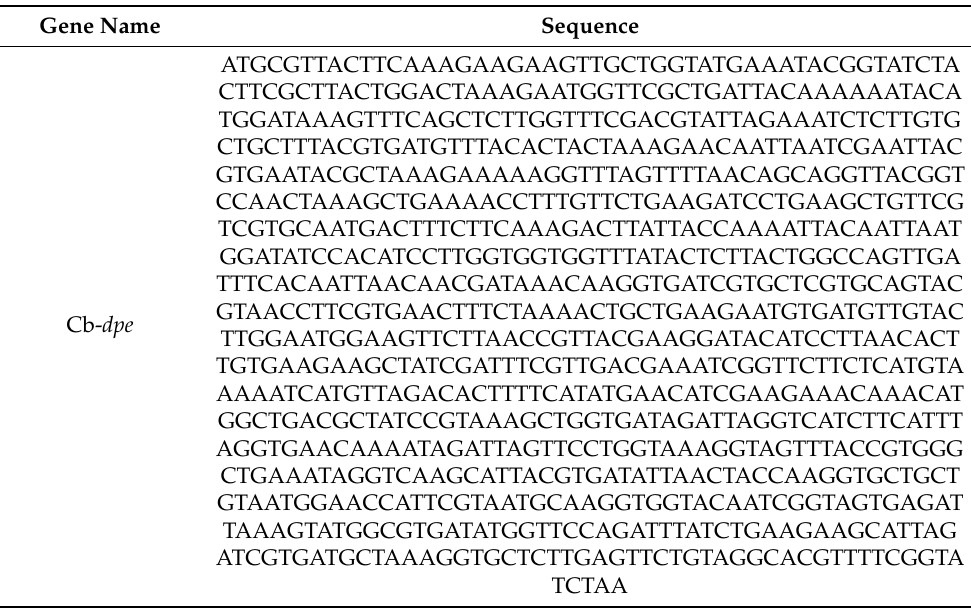
Table A1. Optimized encoding gene